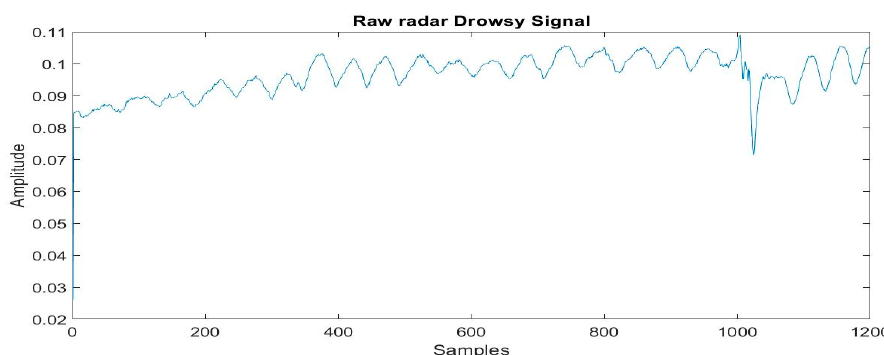
Figure 9. Radar signal for drowsiness.